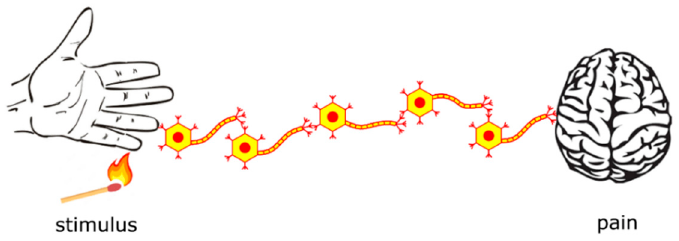
Figure 1. Transmi tt ing and processing information about the stimulus to the brain.